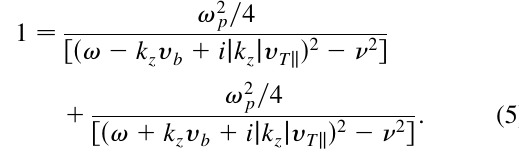
FIG. 11. 3D WARP simulation results for ! the injection conditions summarized in the text. Plot of axial (cid:6) phase space at 0.3 ms after closing the injection elec- (cid:5) z; v z